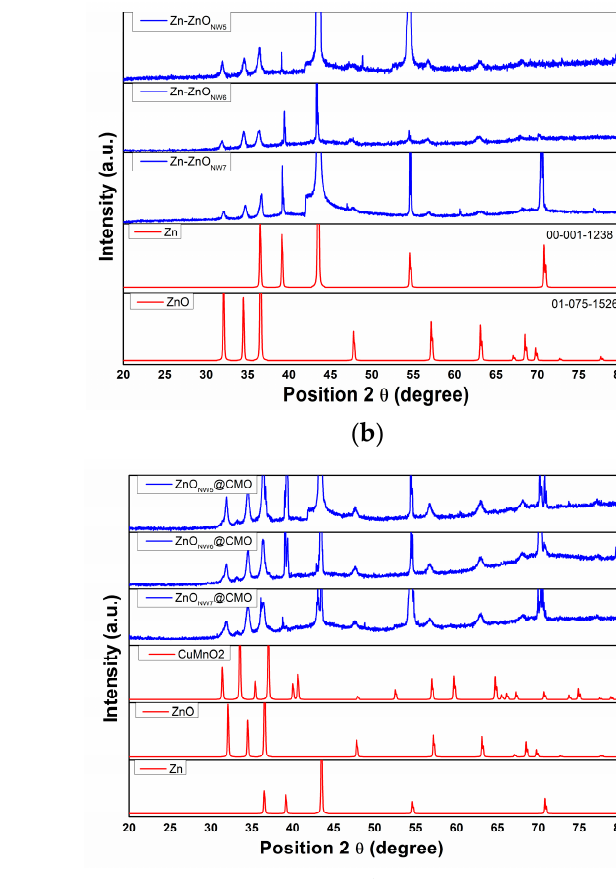
Figure 3. X-ray patterns for Zn- ZnO Nw layers ( a , b ) and as-obtained ZnO Nw @CMO sensors ( c , d ).